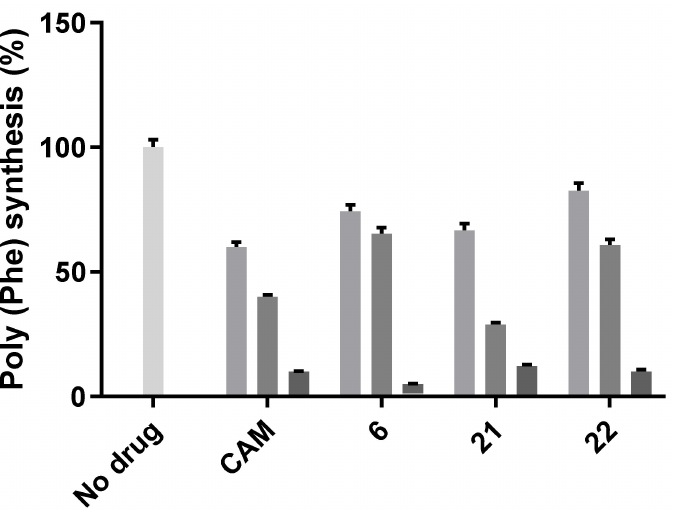
Figure 5. Poly(Phe) synthesis in the presence of CAM and CLB derivatives, at 5, 20 and 50 µ M concentrations for each antibiotic, respectively. Results are expressed as percentage of control (without